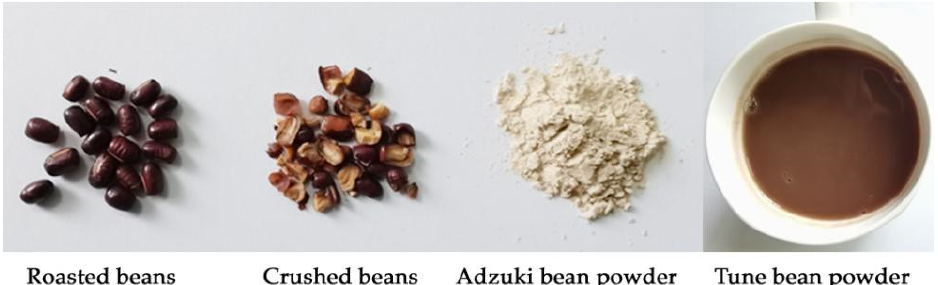
Figure 7. Baked adzuki bean, powder, and tune bean drinks.